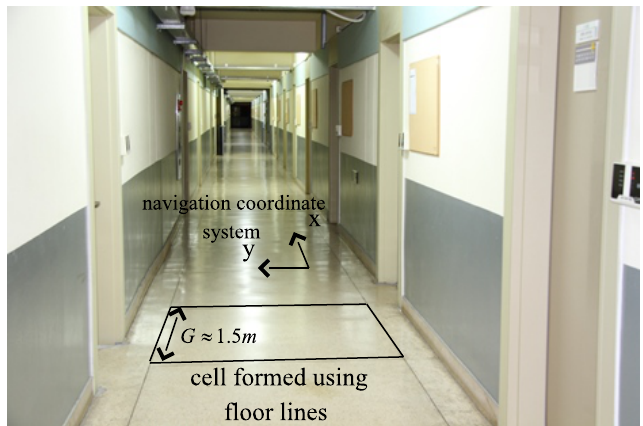
Figure 7. Cells using floor lines in the